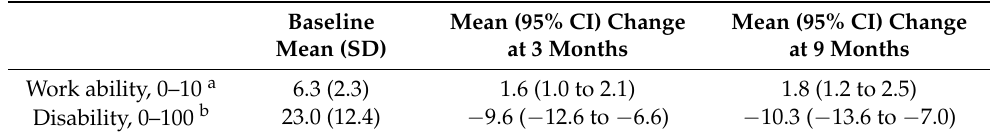
Table 2. Baseline values and estimated mean change of the outcome measures work ability and disability from the baseline values to three- and nine-months follow-up.